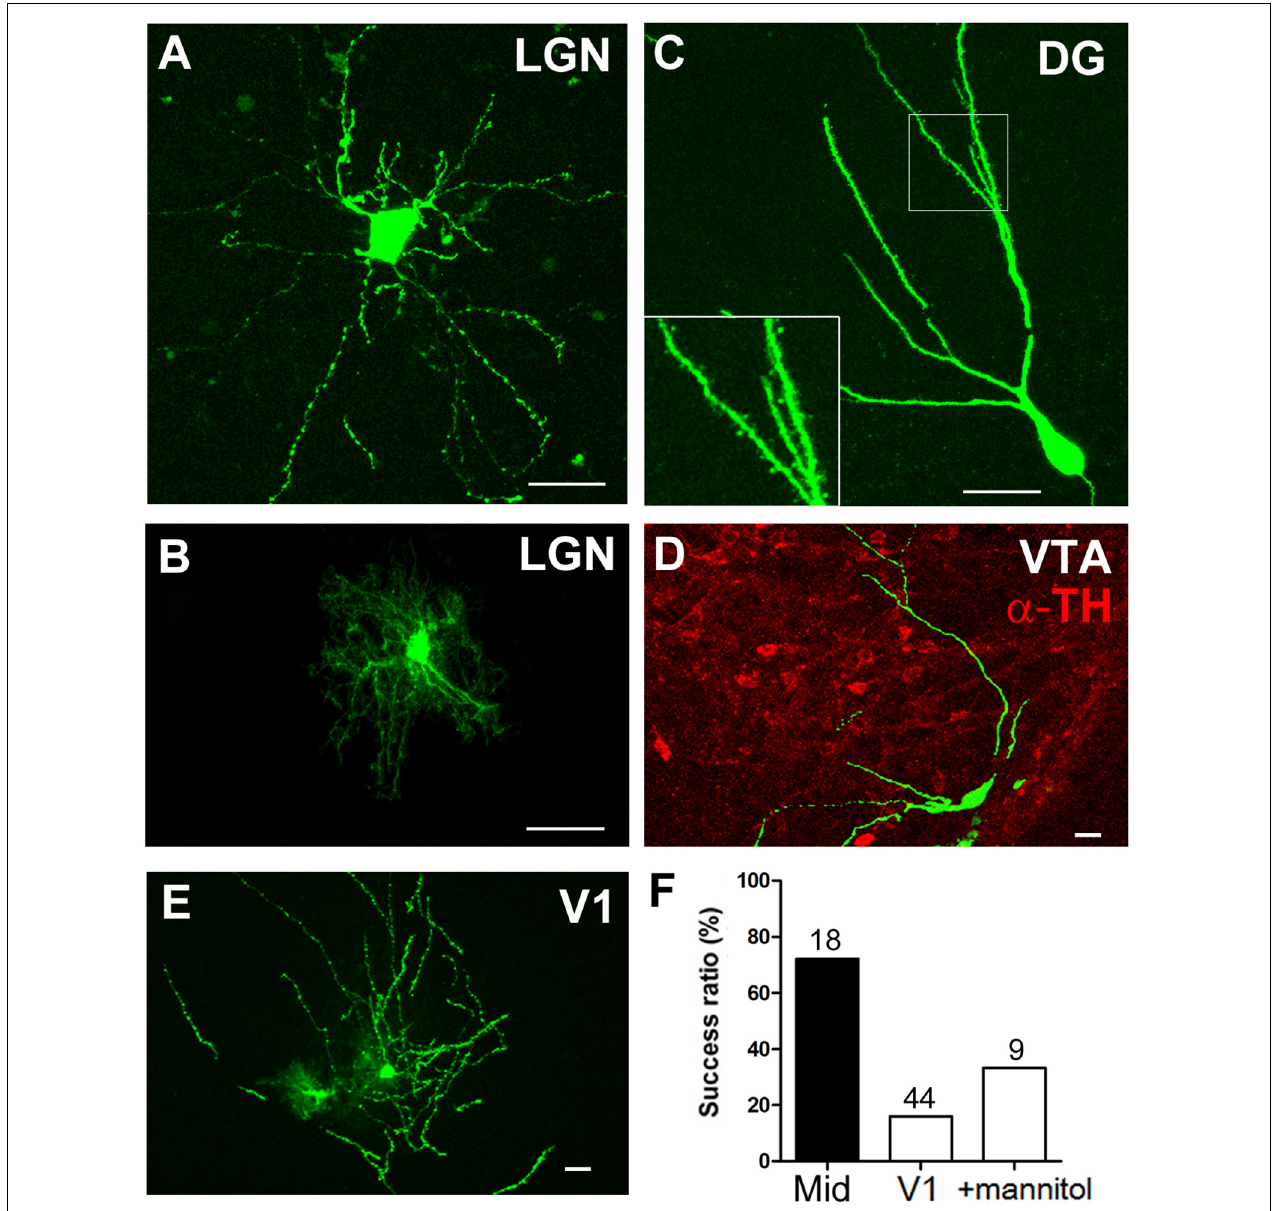
FIGURE 3 | Dendrite morphology of single cells labeled by postnatal electroporation. (A–E) Cell body and dendrites of GFP-expressing cells in the LGN ( A , neuron; B , glia), DG (C) , VTA (D) , and V1 (E) . Dendritic spines were clearly visible in the granule cell ( C , inset). The VTA of the midbrain was identified based on TH immunoreactivity ( D , red). Scale bars, 20 µ m. (F) Transfection efficiency in the midbrain and V1. The percentage of GFP-expressing sites per penetration site after single-site DNA injection and electroporation is shown. Total number of penetration sites is given above each bar.